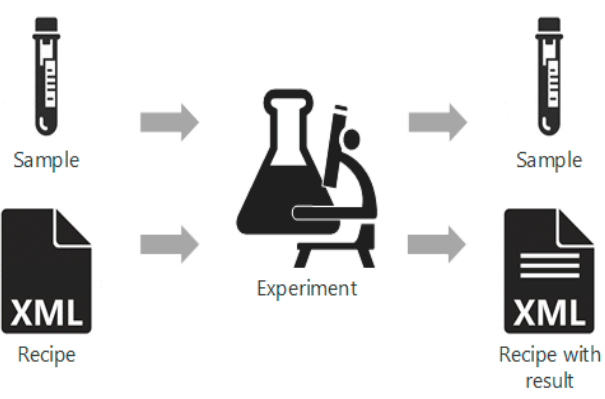
Figure 3. Material and data flow in an experiment process.